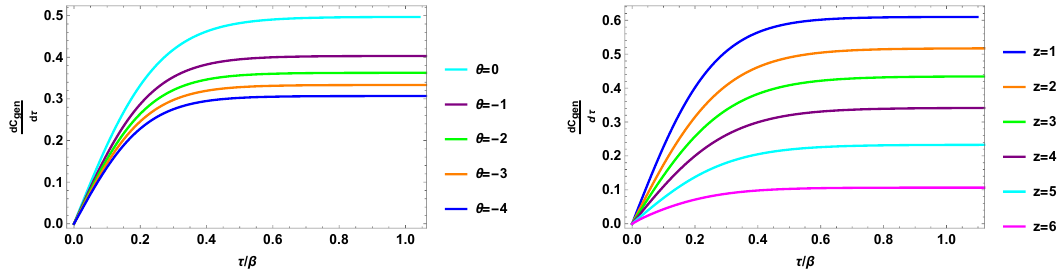
as a function of τ/β for a ( r ) = 1 + λ dτ = 10 − 3 . Right ) d = 2 , θ = 1 and λ 1